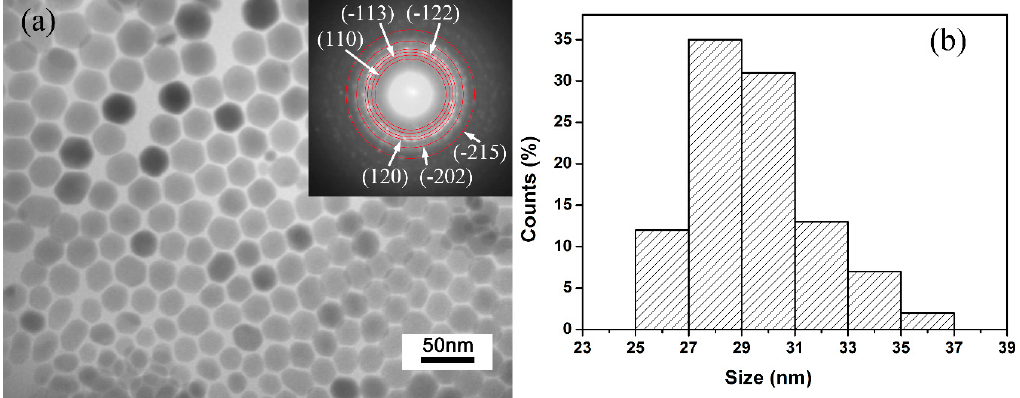
Figure 1. Typical transmission electron microscope (TEM) images and particle size distribution: ( a ) TEM images and selected area electron diffraction (SAED) image (inset) of the samples. ( b ) Size distribution of Ag 2 S nanosheets.